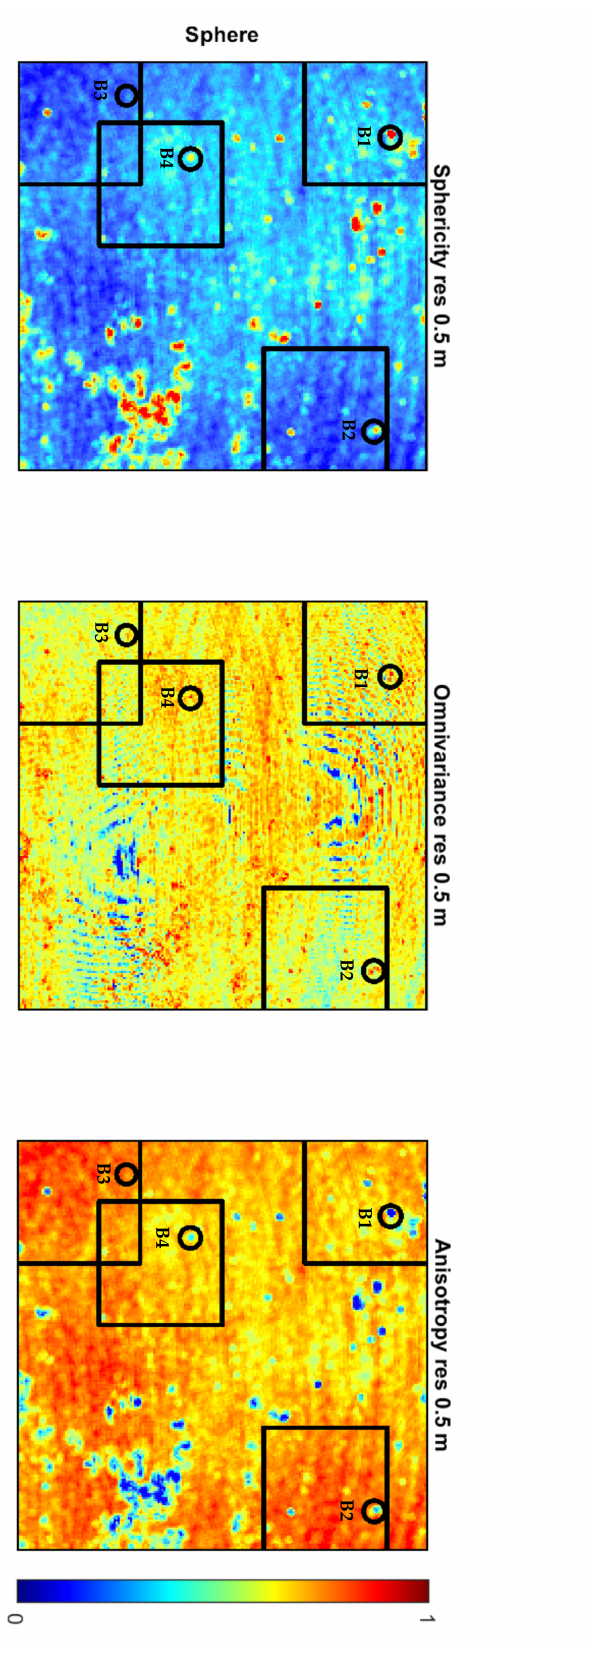
Figure 6. Normalized and centered predictors shown on a 0.5 m grid for the four boulder